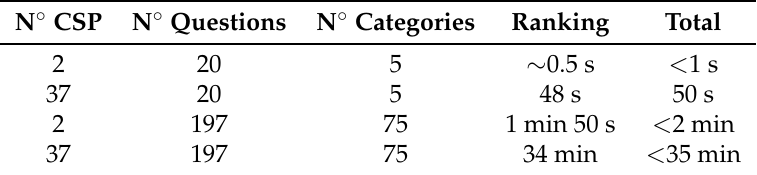
Table 12. Performance Time of Our Approach as a Function of the Number of CSP and the Number of